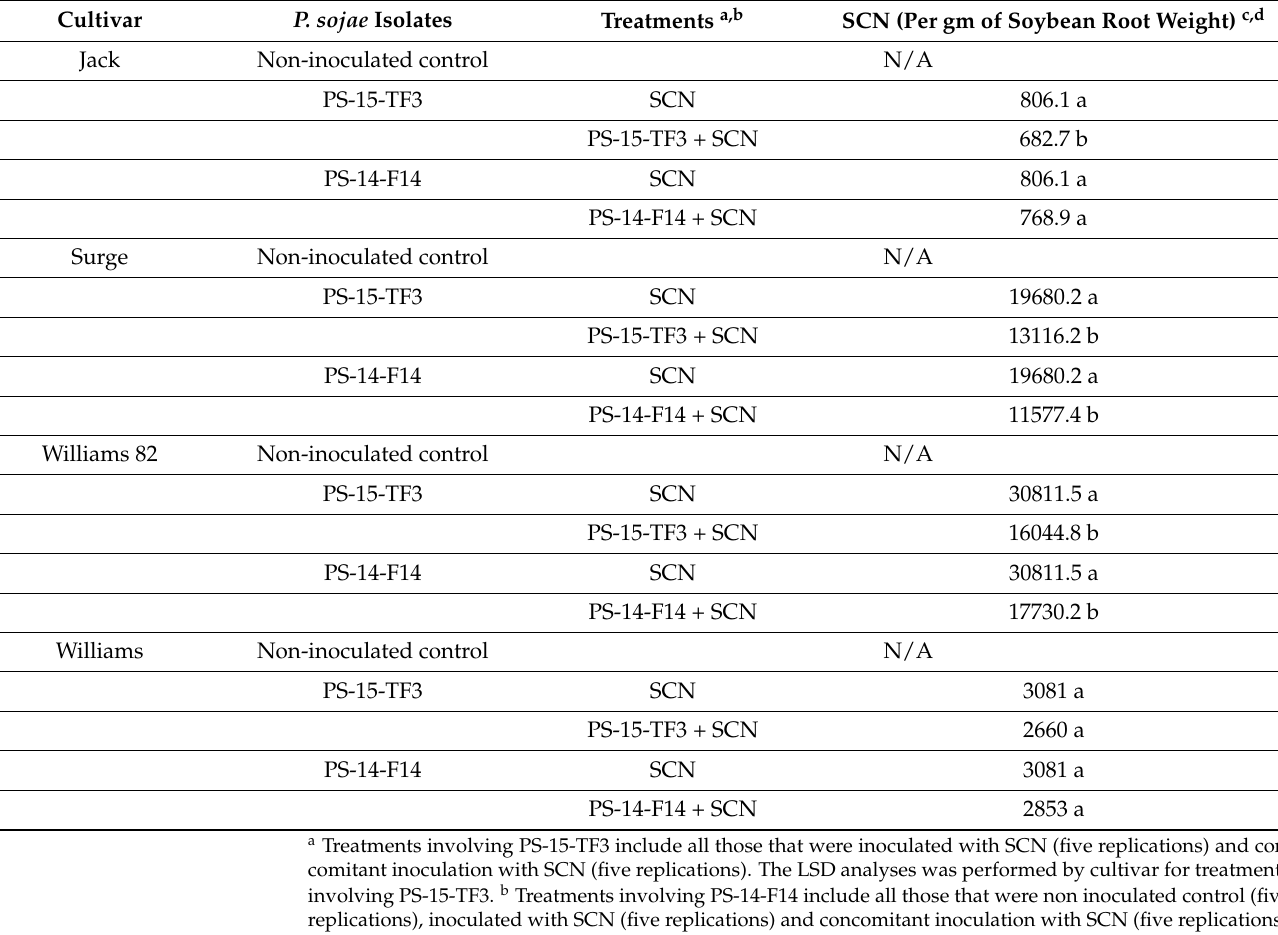
Table 6. Mean number of SCN eggs (per gm of soybean root weight) on each of the four soybean cultivars from